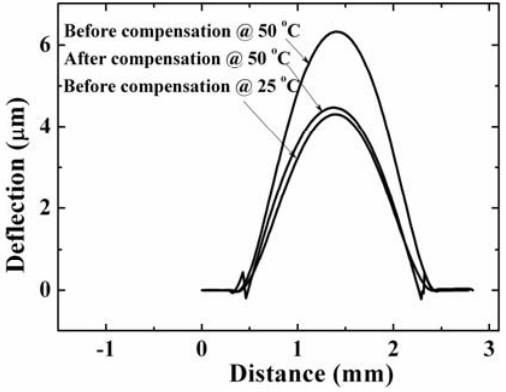
Figure 11. The deflection along diaphragm diameter without Al ring at 25 °C and 50 °C, and the deflection of diaphragm with Al ring with an inside radius of 900 μ m at 50 °C. They are measured by white-light interferometer (Zygo ® NewView 6000, USA). The radius of the diaphragm is 1 mm (not include the sealed ring width), the gap is 8 μ m, and the width of sealed ring is 400 μ